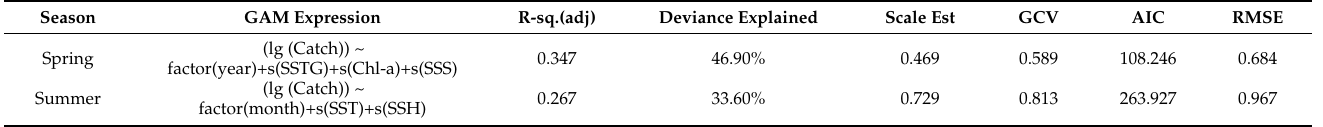
Table 3. Generalized additive models (GAMs) fitted to A. thazard Catch and analysis of